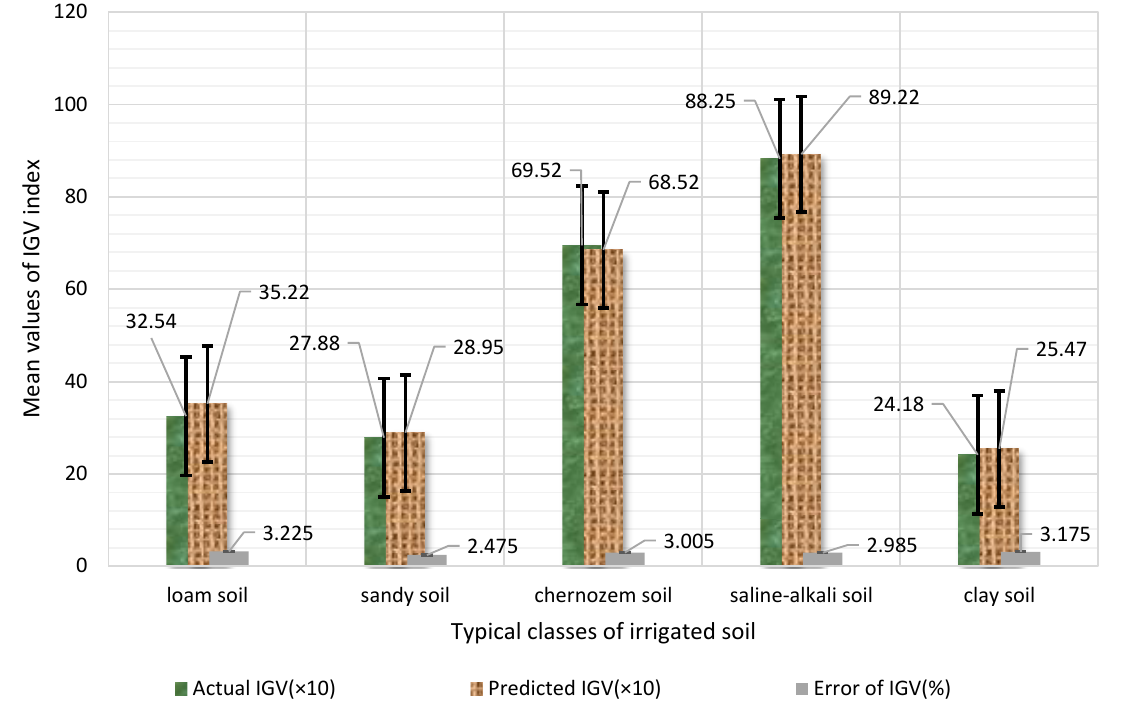
Figure 20. Comparison between the actual and predicted IGV values in typical soil types.